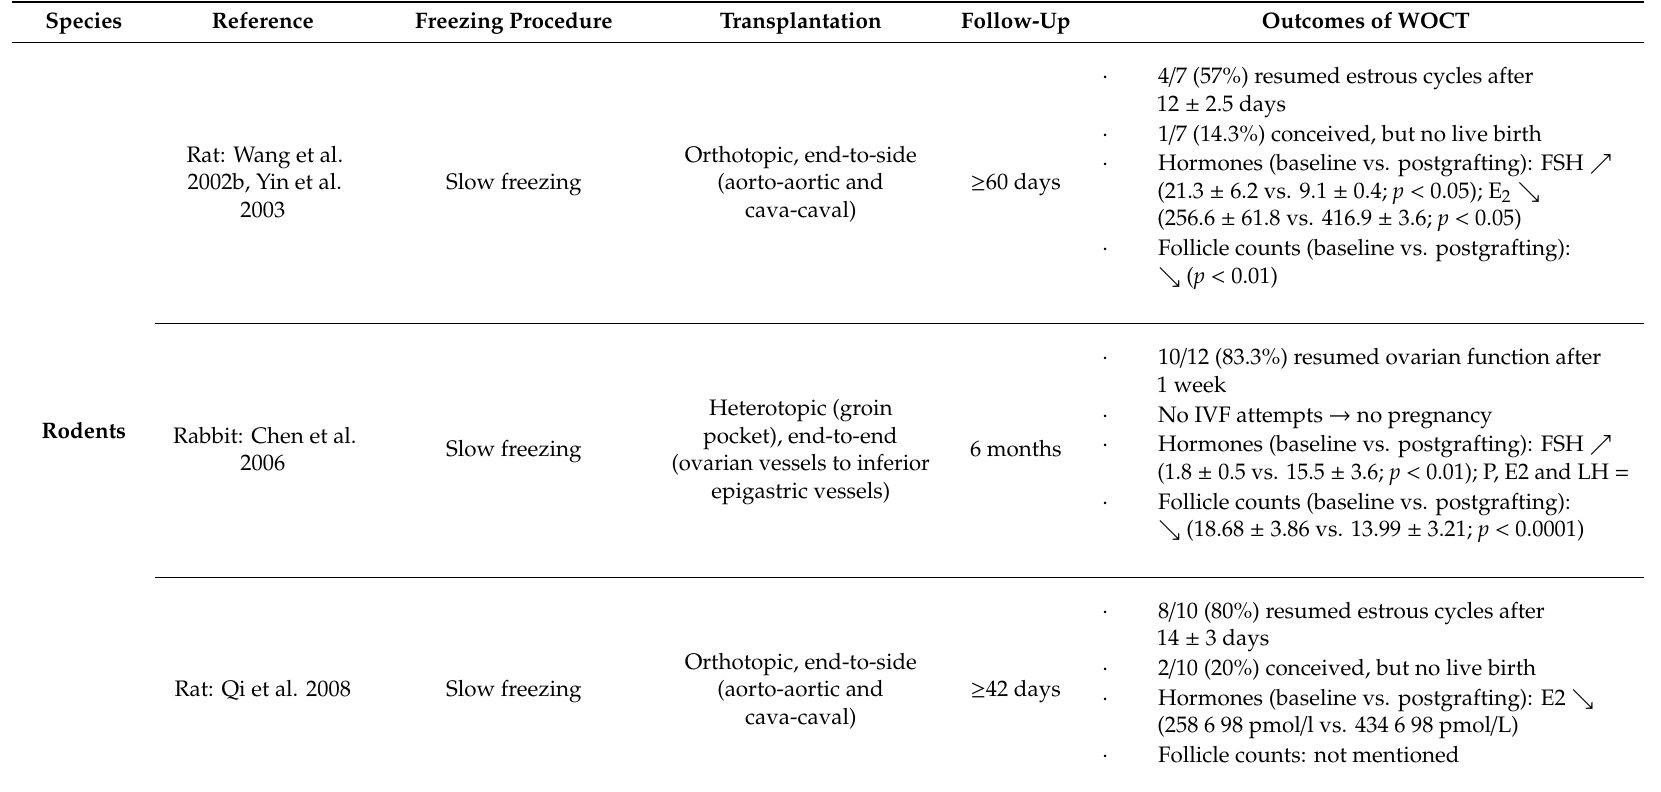
Table 3. Transplantation of cryopreserved whole ovaries in animal